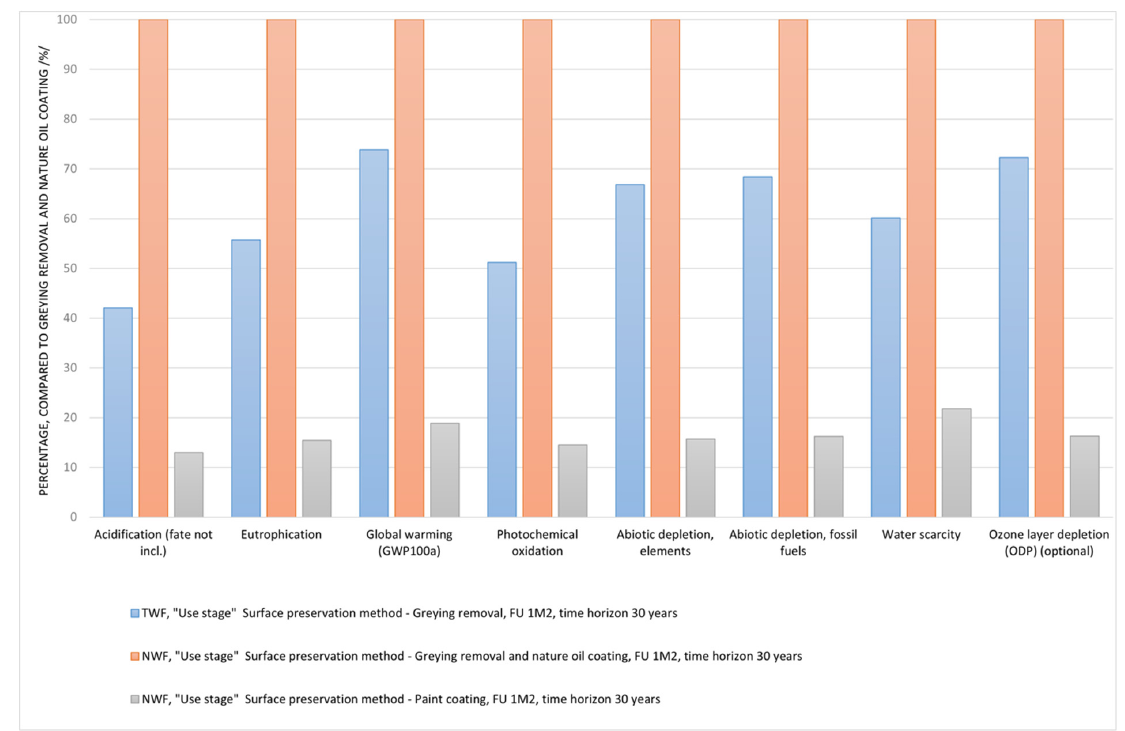
Figure 7. “Use stage” for the functional unit (FU) (1 m 2 ) of TWF with selected surface treatments and NWF with selected coatings; time horizon 30 years. Method EPD (2018) V1.01. TWF—thermally modified wood façade, NWF—non-heat-treated wood façade.